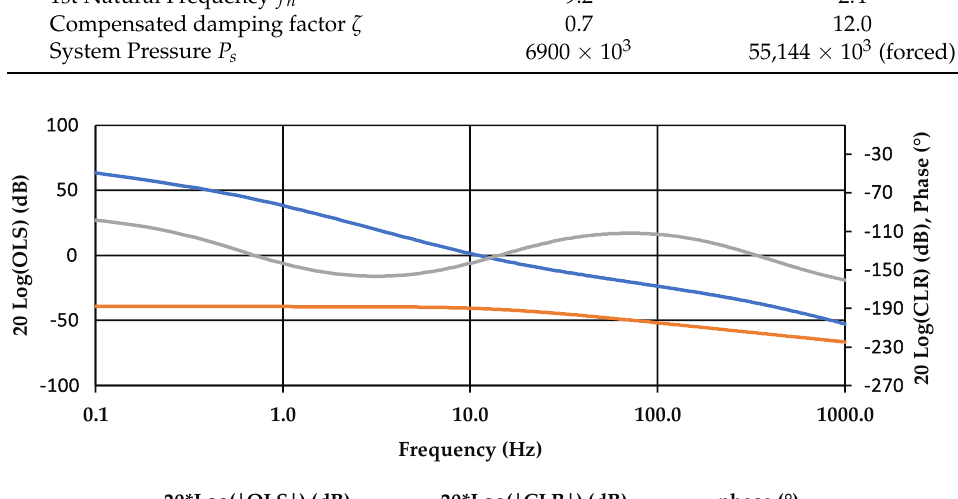
Figure 5. FTF for half power system design solution 3.